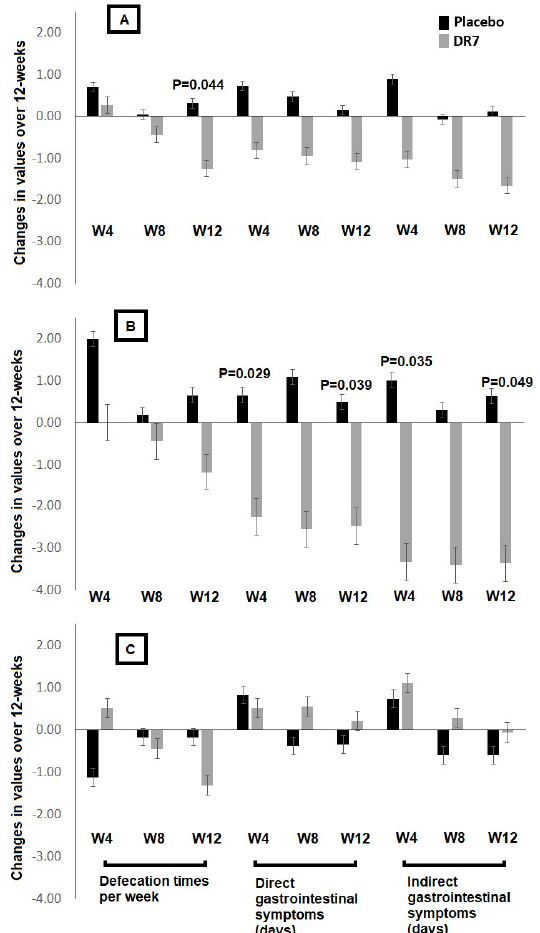
Figure 2. Changes in gastrointestinal clinical outcomes after 12 week administration of Lactobacillus plantarum DR7 compared to the placebo group in ( A ) all subjects, ( B ) young adults (aged < 30 years old), and ( C ) normal adults (aged > 30 years old). Direct gastrointestinal symptoms included vomiting, dysentery (blood in stool), abdominal pain, nausea, and rectal pain (sharp dull, burning, feels like a hard object in the rectum); indirect gastrointestinal symptoms included loss of appetite, fatigue, dizziness, headache, dehydration, and fever; number of defecation times were calculated based on a weekly basis. p -values indicated the difference between treatment groups at individual time points. Results are expressed as mean, error bars (SEM); n = 111 (DR7 n = 56 and placebo n = 55).